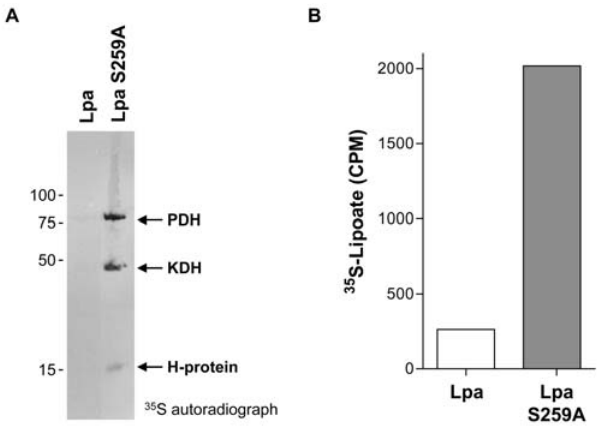
Figure 2. Uptake and incorporation of 35 S-lipoic acid in the presence of Lpa. ( A ) KER176 cells that are auxotrophic for lipoic acid were transformed with plasmids encoding wild type Lpa (Lpa) or the active site nucleophile mutant Lpa S259A and were grown in minimal medium supplemented with 35 S-lipoic acid. After a 10 hour induction at 20 u C, cell samples were normalized by OD 600 and protein extracts were separated by SDS-PAGE and analyzed by autoradiography. The assignment of the labeled species to the three lipoylated proteins in E. coli , the PDH, KDH, and H-protein, is indicated. ( B ) Scintillation counting was used to quantify 35 S-lipoic acid taken up by the KER176 cultures shown in Figure 2A . Counts per minute (CPM) correspond to the uptake of cells from 5 m l of culture with an OD 600 of 1.1.